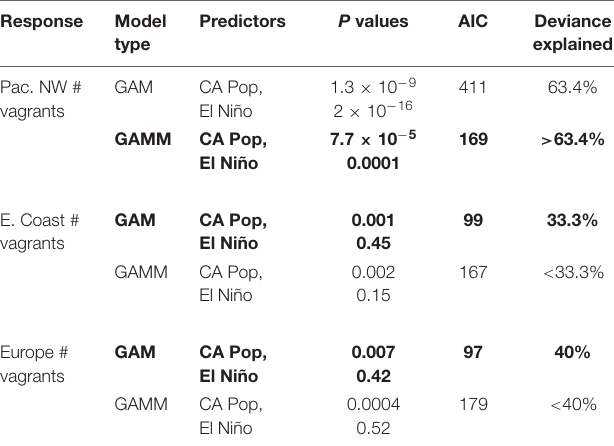
TABLE 3 | Summary of GAM results for vagrancy